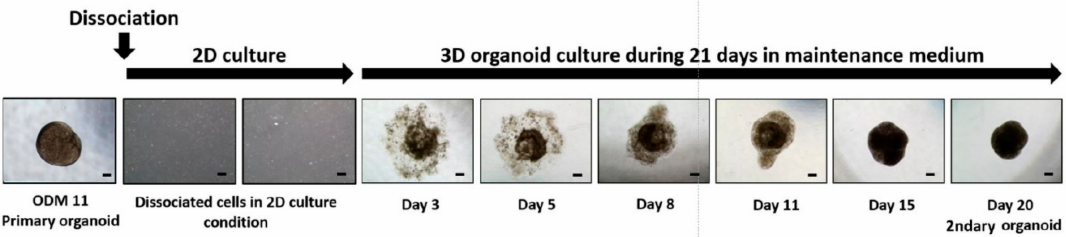
Figure 4. Dissociation and refabrication of organoid confirmed that ODM 11 consisted of viable cells. Primary dentin-pulp-like organoid from ODM 11 was dissociated using trypsin EDTA. After 12 days of culture, cells were cultured again using organoid MM. During primary dentin-pulp-like organoid fabrication, dissociated cells started to aggregate and formed the organoid at 21 days again. Representative images were taken under a light microscope. Scale bar = 100 µ m, MM: maintenance